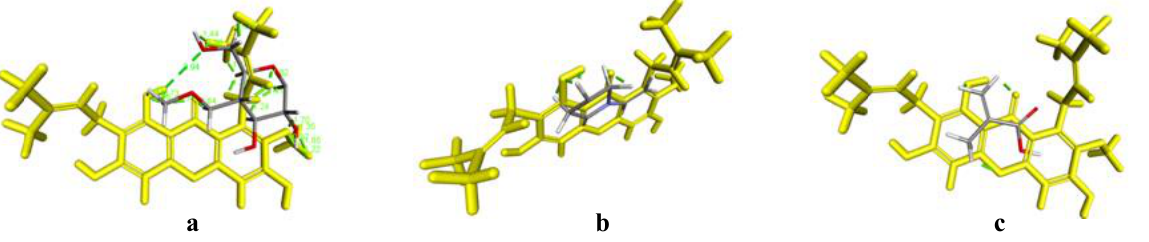
Figure 9. 3D Visualization of AM with ( a ) HPMC, ( b ) PVP, and ( c ) eudragit.